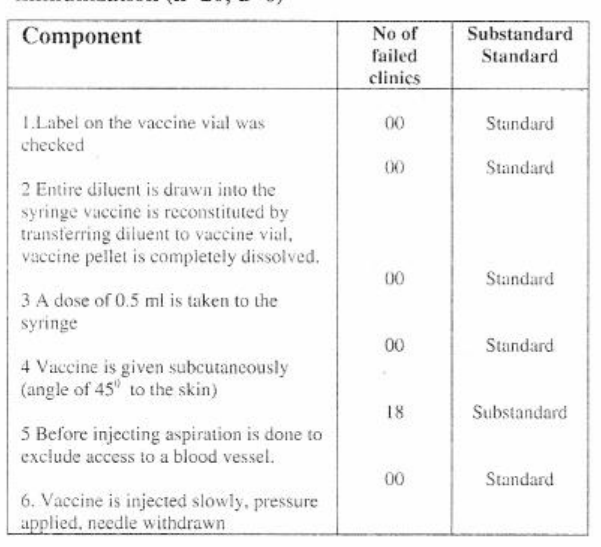
Tab 2. Assessmentof cold chain maintenancein ion of rubella immunizationatclinics in prov